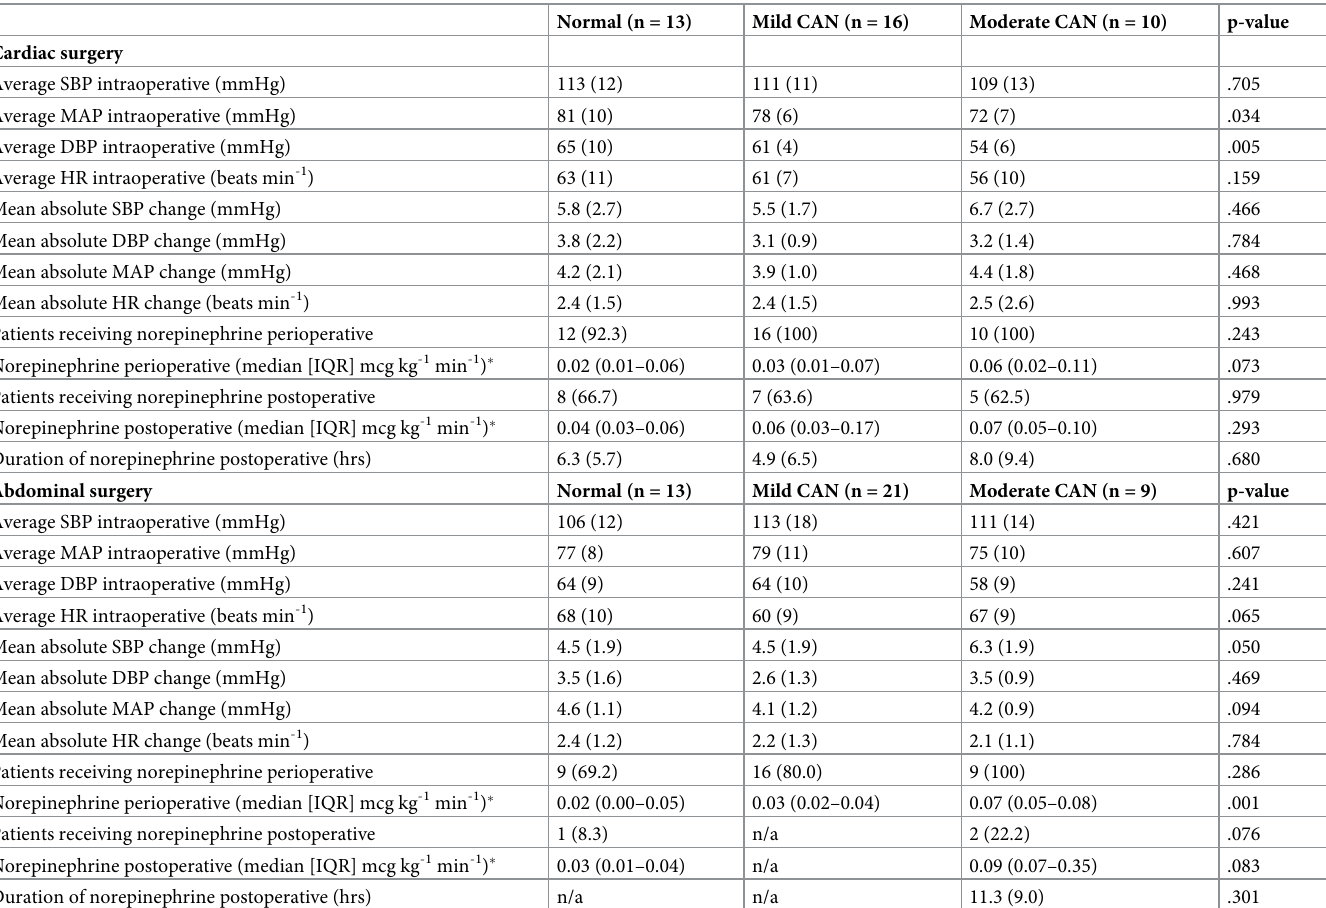
Table 3. Univariate analyses, association of CAN and intraoperative haemodynamic variables for cardiac and abdominal